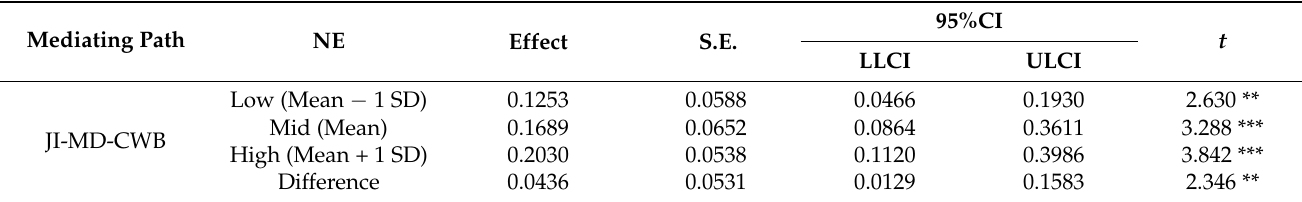
Table 5. Bootstrap results for the moderated mediation effect analysis of NE.